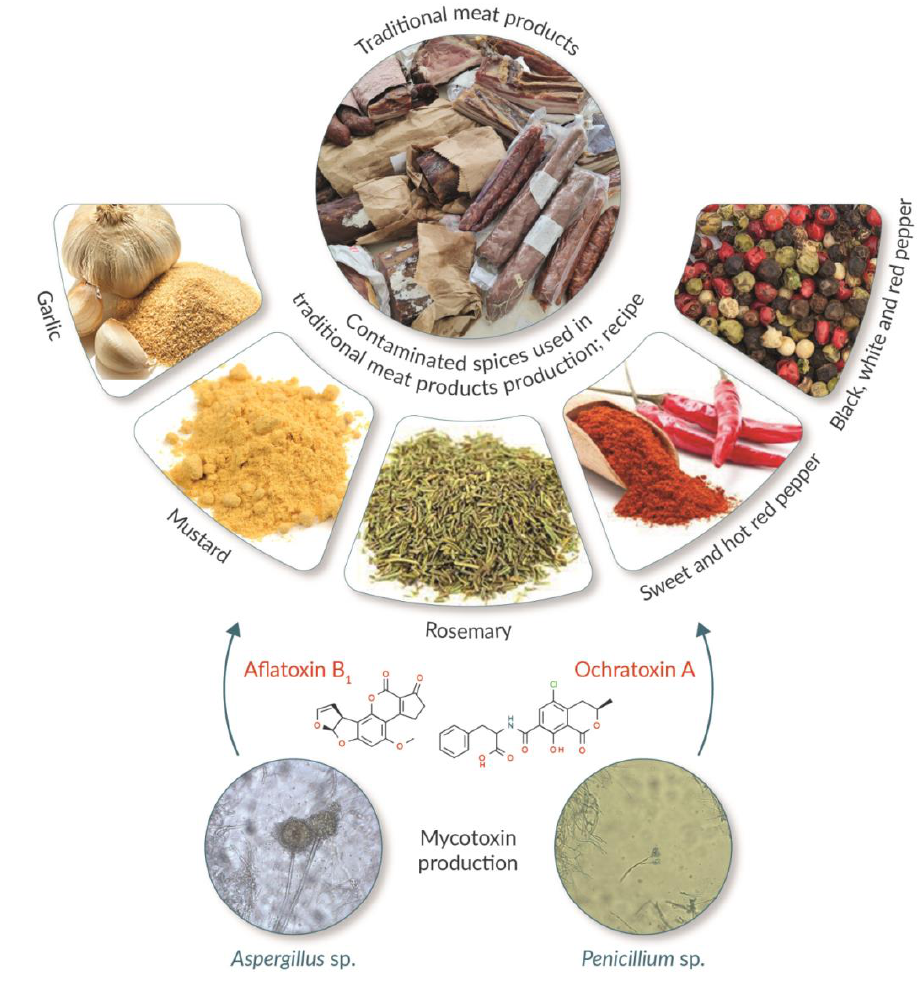
Figure 1. The use of different spices in meat production.